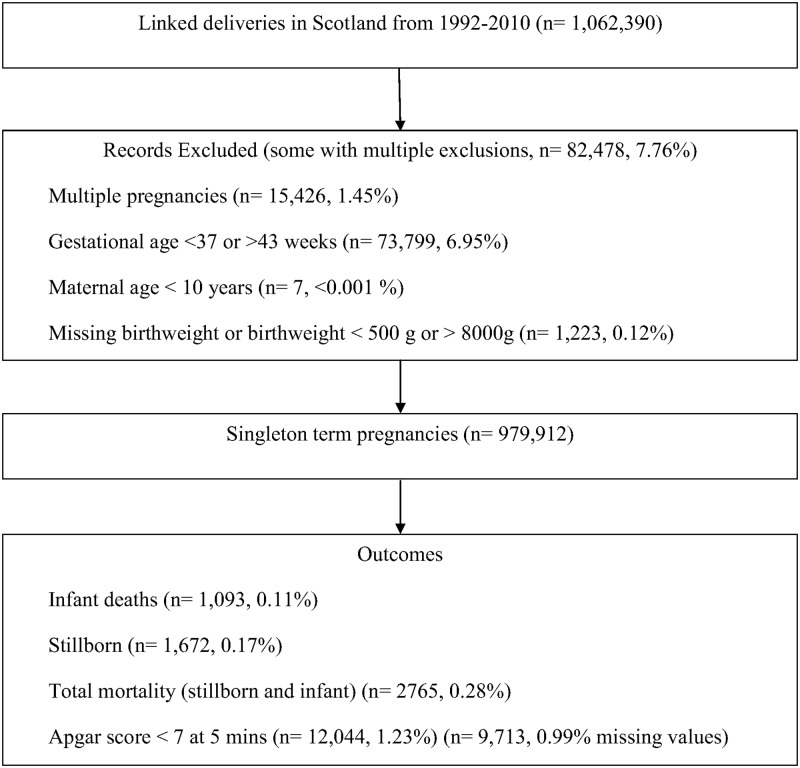
Definition of eligible cohort and analysis sample.